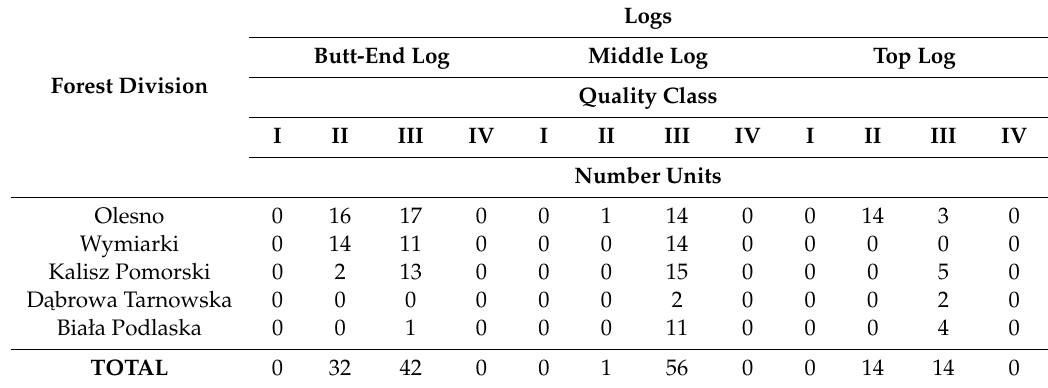
Table 7. Amount of sawn timber by defect: bark pockets / resin pitches ( PN-75 / D- 96000